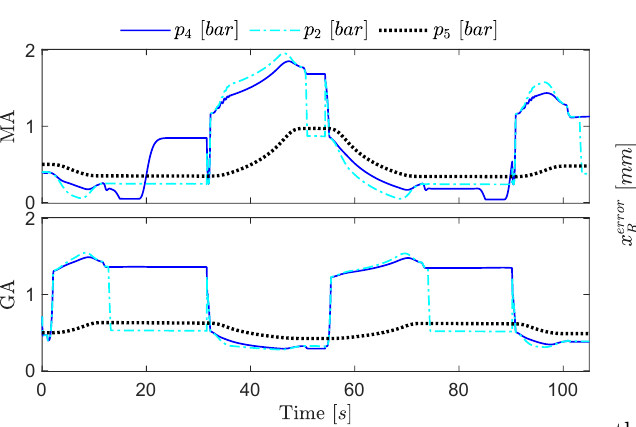
Figure 27: SCC’s high pressures: (red) piston-side cham- ber; (green) pump supply.